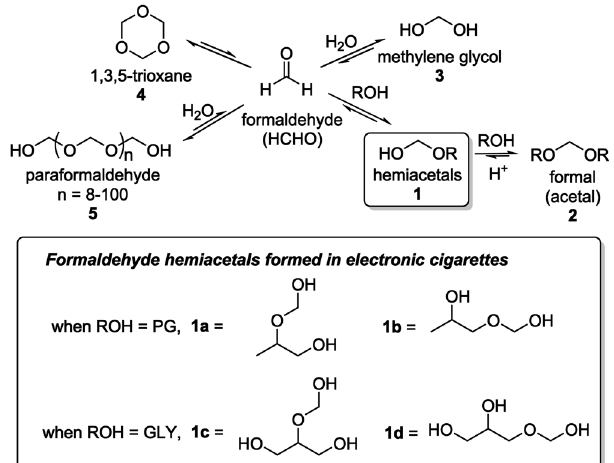
Figure 1. Gaseous formaldehyde (HCHO) and examples of its common equilibria. Balashov 7 found